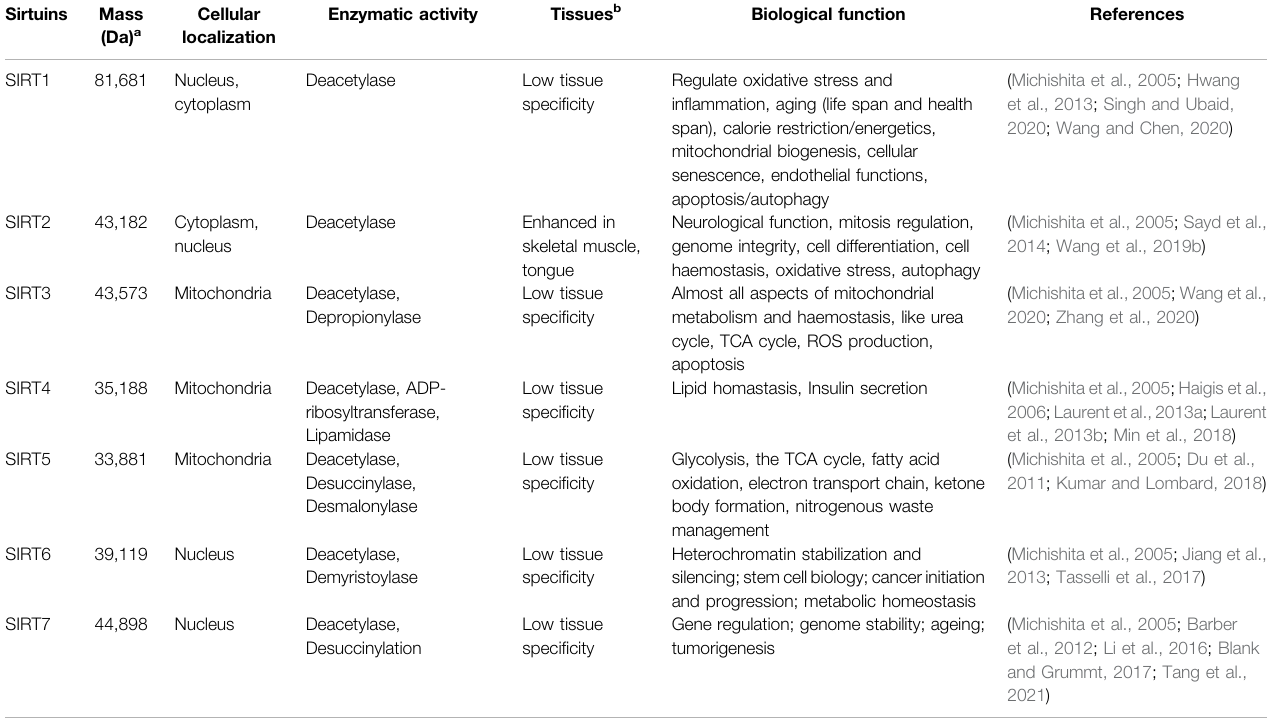
TABLE 1 | Characteristics of sirtuins including mass, cellular localization, enzymatic activity, tissues and biological functions.